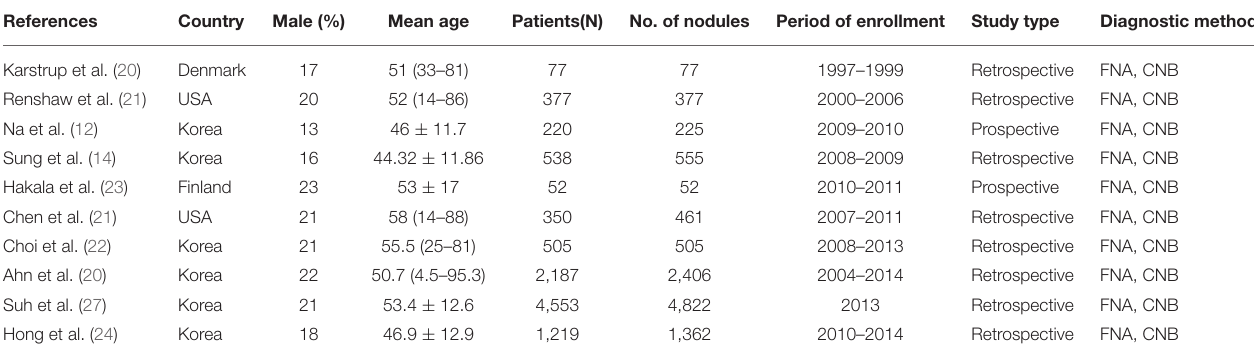
TABLE 1 | Characteristics of the studies included in this meta-analysis.